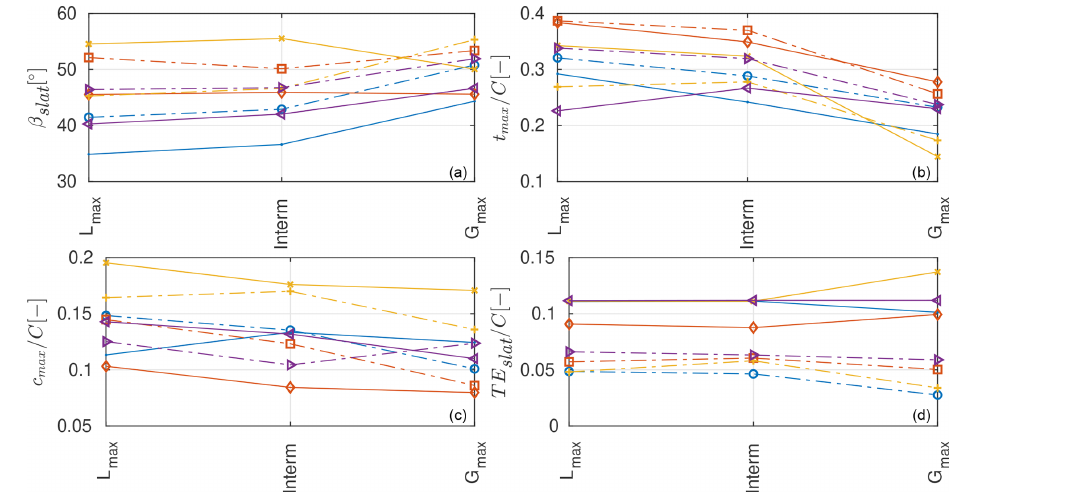
Figure 9. Slat characteristics from the auxiliary ( − ) and the integral ( − . ) design procedures in terms of (a) slat angle, (b) slat thickness, (d) slat camber, and (d) slat streamwise trailing-edge location.